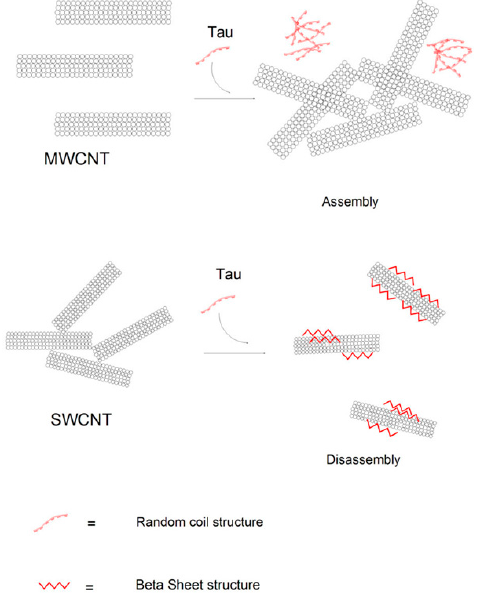
Figure 4. Schematic illustrating single-walled carbon nanotubes (SWCNTs)-induced interactions with tau protein structure, resulting in pronounced conformational changes and corresponding denaturation compared to multi-walled carbon nanotubes (MWCNT)